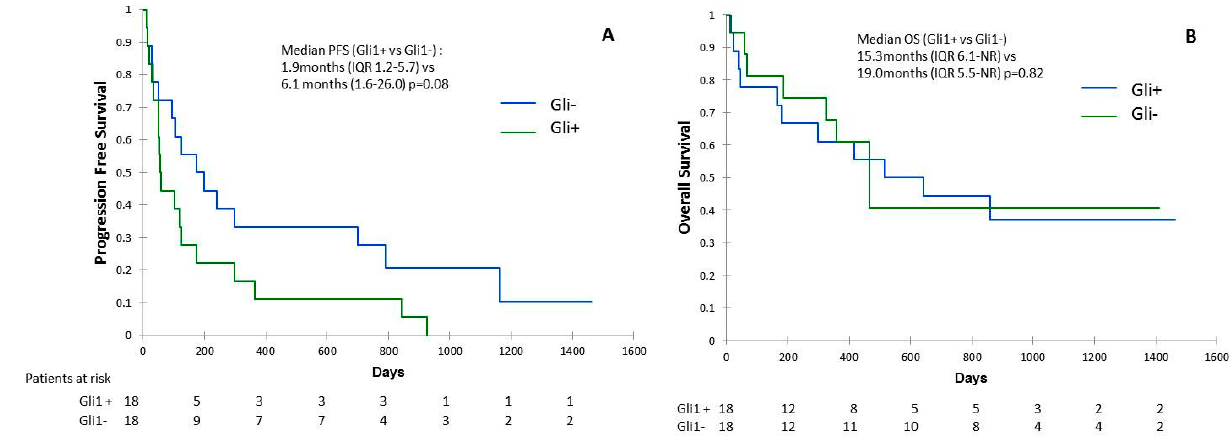
Figure 2. Progression-free survival (PFS) ( A ) and overall survival (OS) ( B ) according to Gli1 expression in immunohistochemistry.